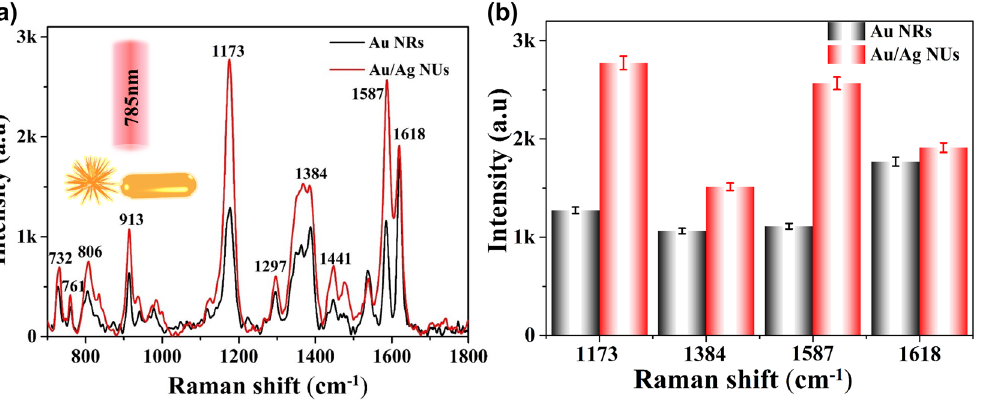
Figure 3: SERS performances of Au/Ag NUs and Au NRs in the single laser system. (a) Raman spectra of 10 − 5 M CV molecules separately performed in the presence of Au/Ag NUs and Au NRs in solution. (b) The comparative results of Raman intensities of CV molecules on two nano-substrates (each error bar indicates the standard deviation of 10 different